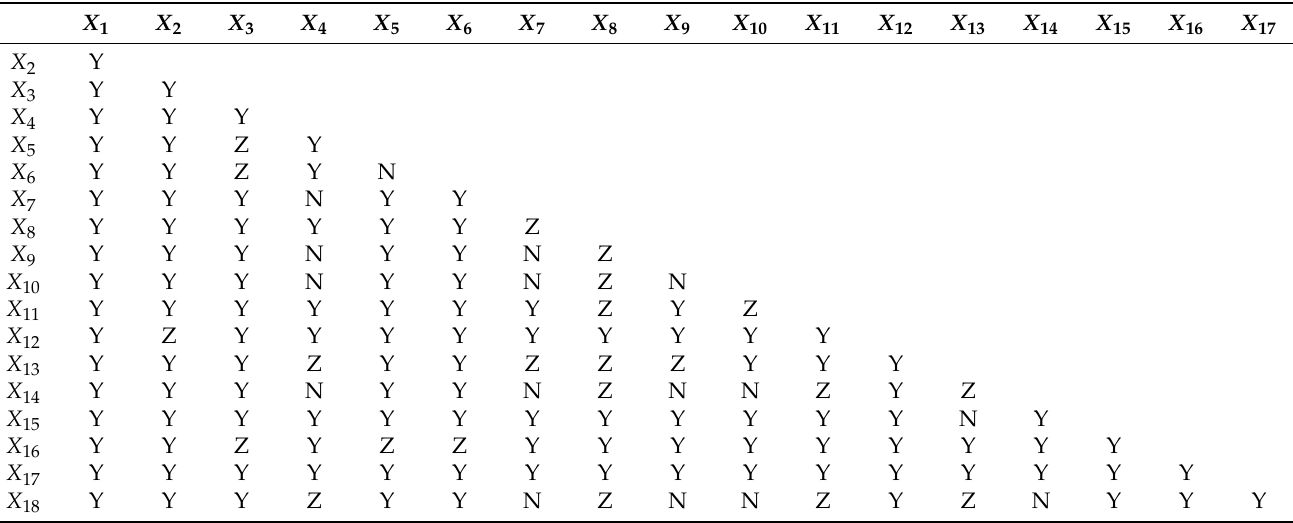
Table 4. Significance test of the impact on habitat quality of